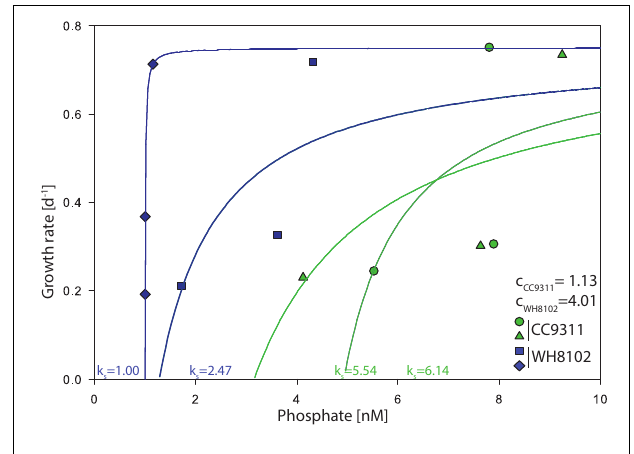
FIGURE 1 | Growth rate as a function of external phosphate concentration for Synechococcus strains WH8102 and CC9311 in 4 chemostat vessels. The half saturation concentration for growth (K s , p ) values were determined using a modified Monod’s growth rate kinetics equation. The blue curves represent the replicated WH8102 strains while the green curves represent the replicated CC9311 curves. The draw down concentrations c are noted for WH8102 and for CC9311.